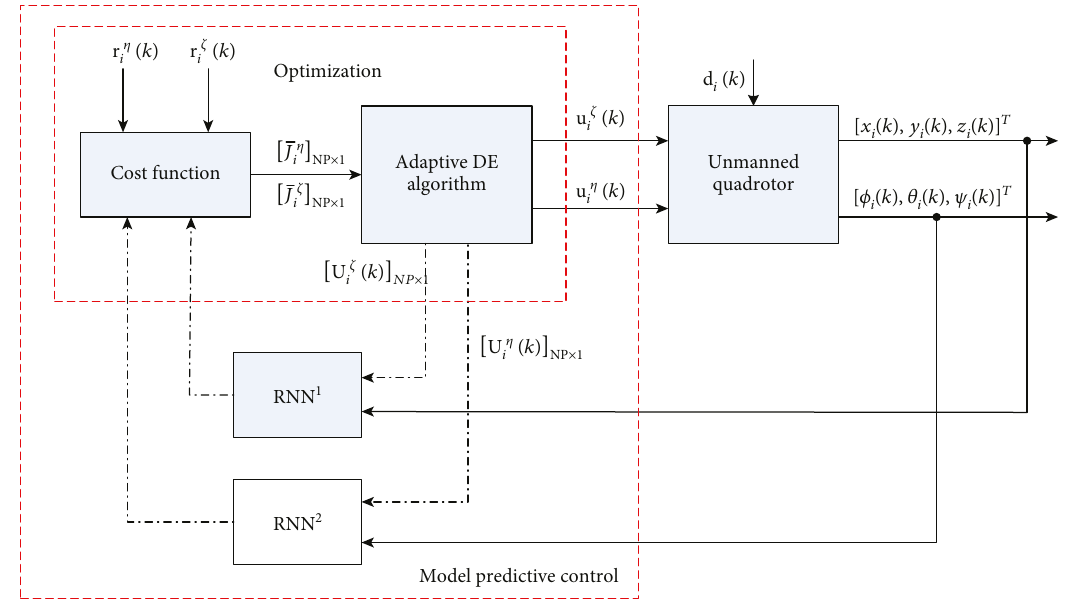
Figure 5: MPC structure based on RNN for each unmanned